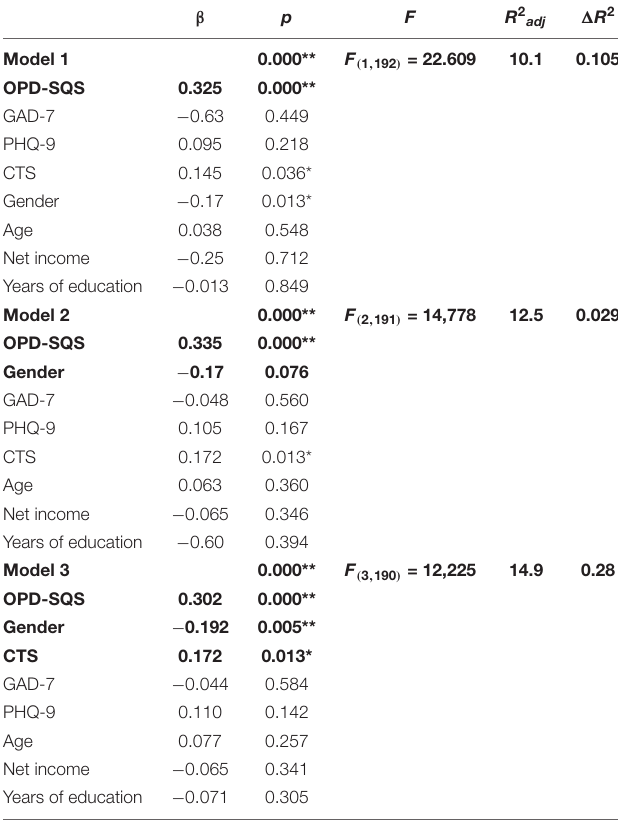
TABLE 3 | Summary: predicting non-adherence in linear stepwise regression analysis.